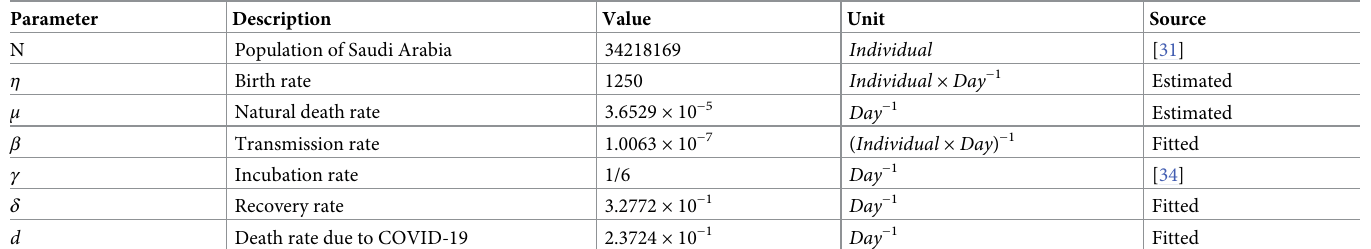
Table 1. The description and values of the basic parameters in model (1).